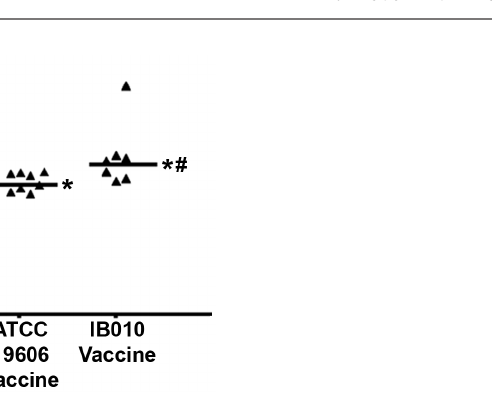
Figure 3. Effect of vaccination on tissue bacterial loads. Immunized and control mice were infected with 2.0 6 10 6 cfu (300 6 LD 50 ) of the ATCC 19606 strain and spleen bacterial loads were determined 12 hours post-infection (n 5 8 mice/group). Data points represent bacterial loads from individual mice, and horizontal lines represent median values from groups of mice. * p , 0.05 compared to control mice. # p , 0.05 compared to ATCC 19606 vaccinated